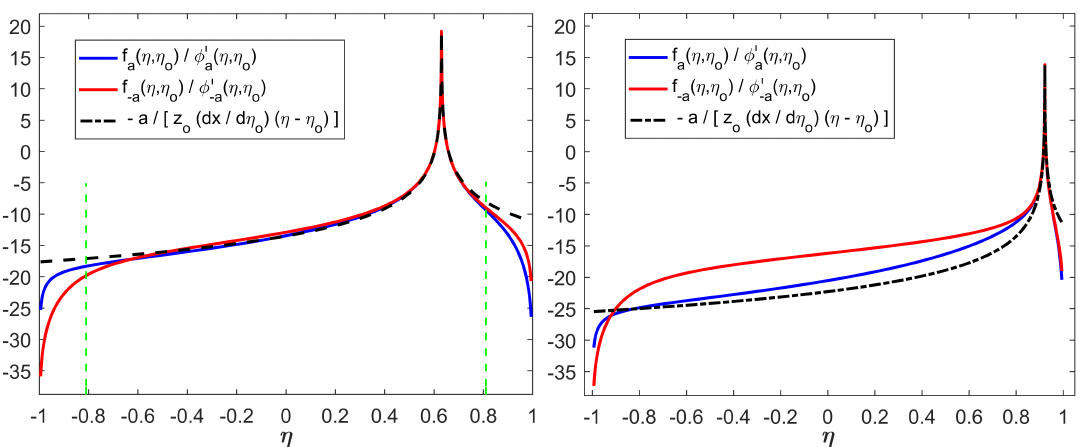
( η − η o )] in terms of d η o